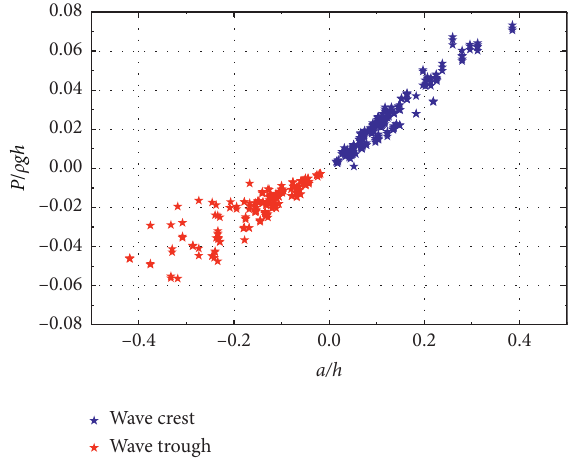
Figure 11: Relative wave pressure with respect to the relative wave